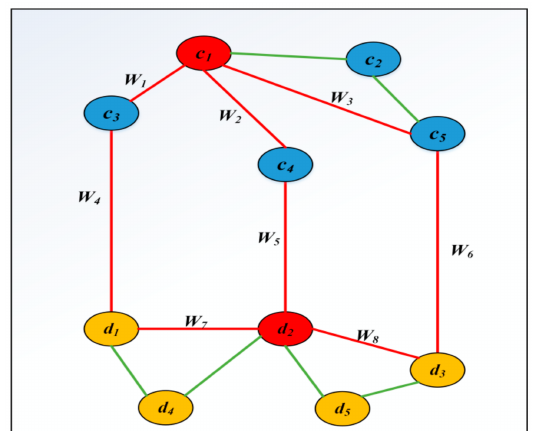
Figure 4. The path between c 1 and d 2 is within the maximum path